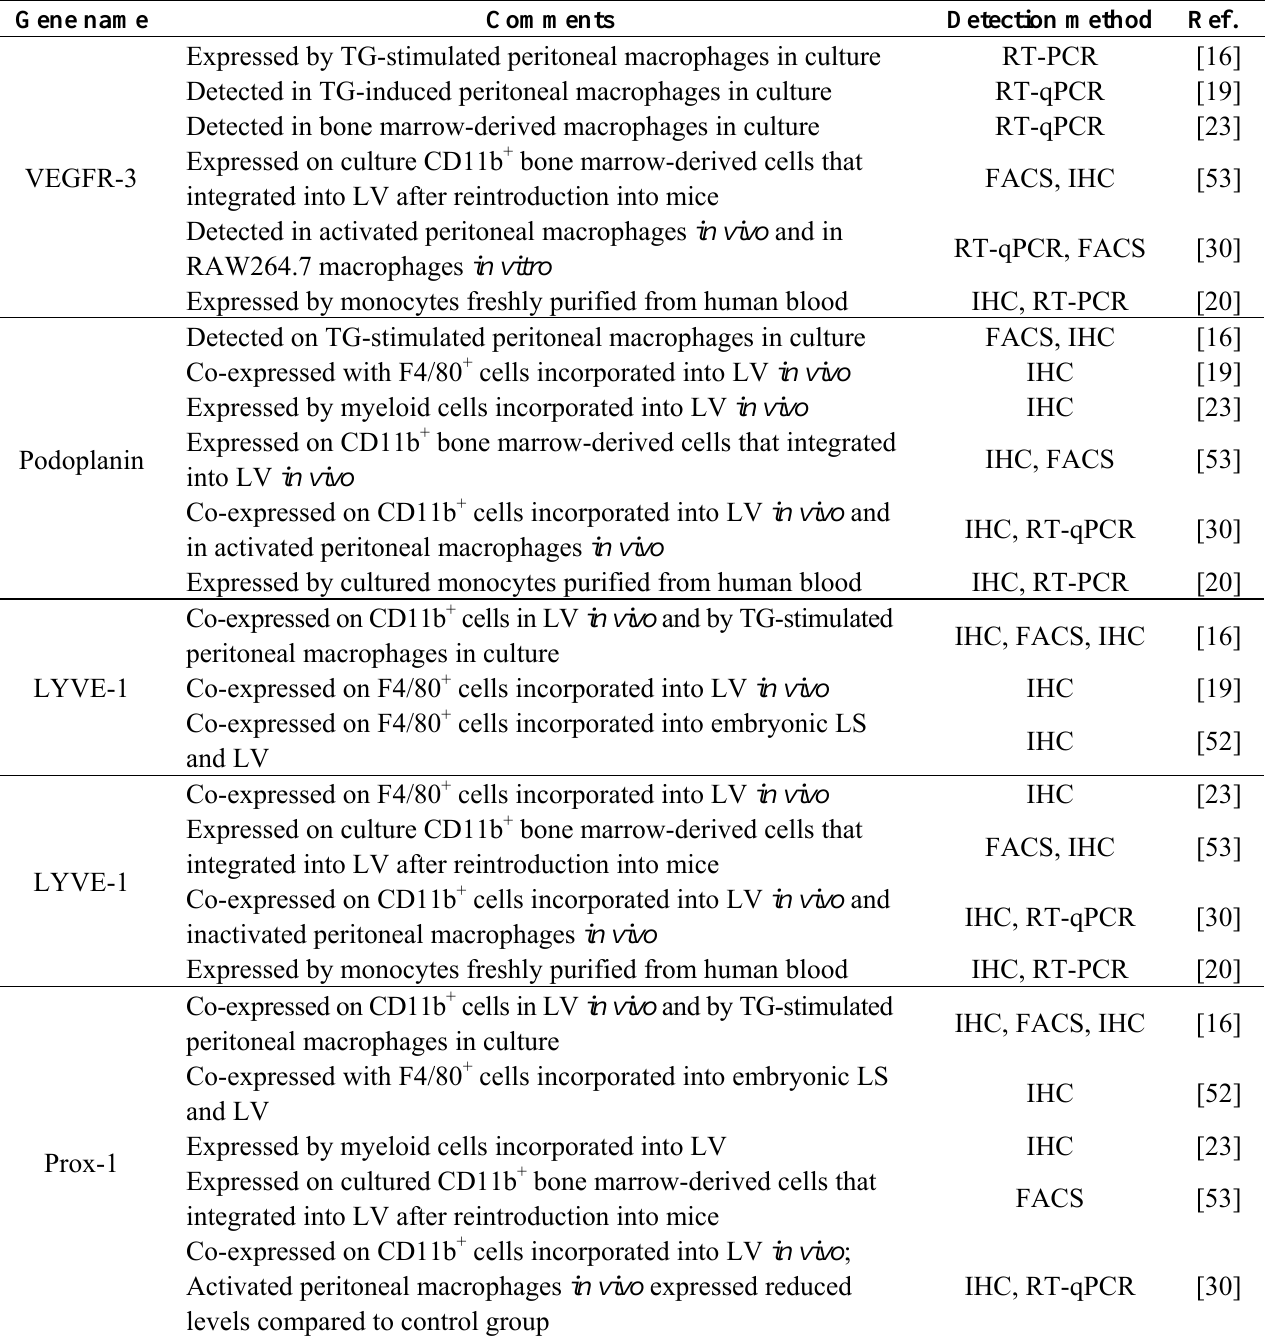
Table 3. Reported expression of LEC markers by macrophage-derived lymphatic endothelial cell progenitors